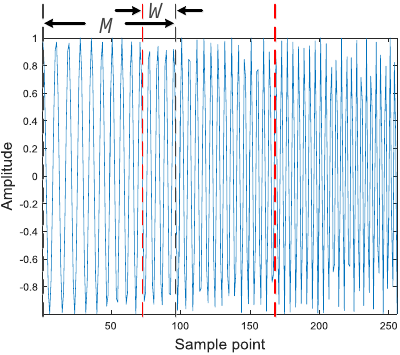
Figure 8. Signal segmentation diagram.